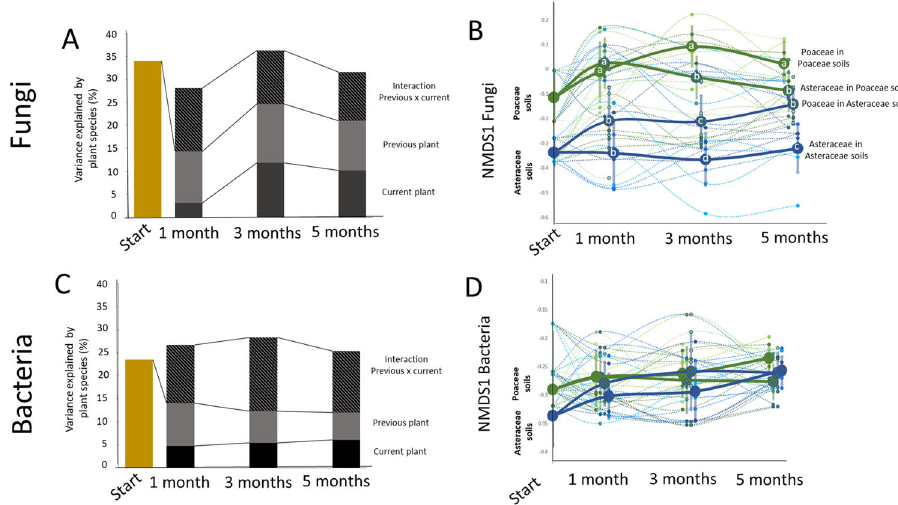
Fig. 3 Effects of current and previous plants and their family on soil microbiomes. Variance in fungal ( A ) and bacterial ( C ) community structure in soils explained by current and previous plant species and their interaction in the beginning (explained by the then current but later referred as previous plant species) of the experiment, and after 1, 3, and 5 months. Changes in community structure of fungi ( B ; depicted as NMDS1, for full data see supplementary fi gure 1) and of bacteria ( D ; depicted as NMDS1, for full data see supplementary fi g. 2) in time and per plant species (thin lines, n = 5) and averaged per plant functional group (thick lines, n = 45) are presented. The colors refer to plant species, green colors mark Poaceae and blue colors Asteraceae. The circles note the average value for NMDS1 for each combination of previous and current plant families ( n = 30) and error bars of points on the thick line depict the standard error between plant species from same families. The letters in the circles note statistical signi fi cance of the Tukey post doc test between combinations of families of current and previous plant estimated with lme model where the identity of current and precious plant was used as random factors (Fig. 1). The 2D stress values of the across time points ordinations were 0.19 for fungi and 0.21 for (PerMANOVA R 2 R 2 = 0.06 for bacteria and R 2 = 0.09 for fungi,